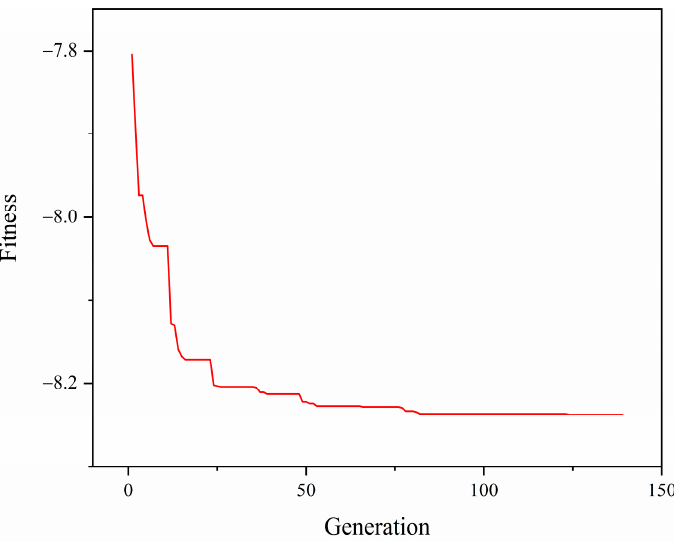
Figure 20. The variation curve of fitness with iterations of population evolutionary